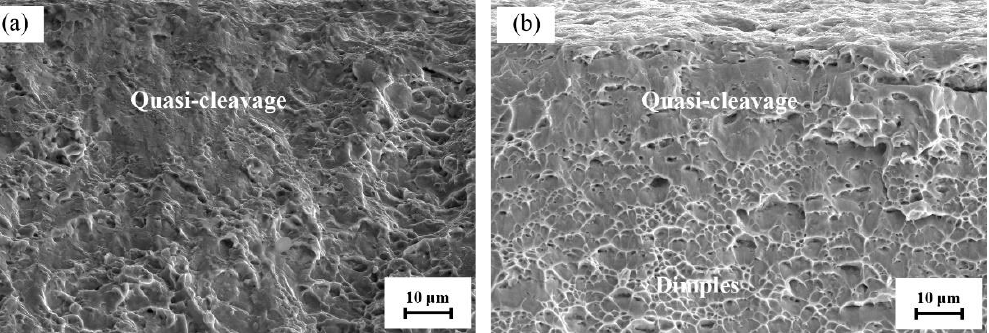
Figure 12. The stress–strain curves ( a ) and elongation ( b ) of Ti6Al4V alloy after 1 h charging under different DO concentrations.